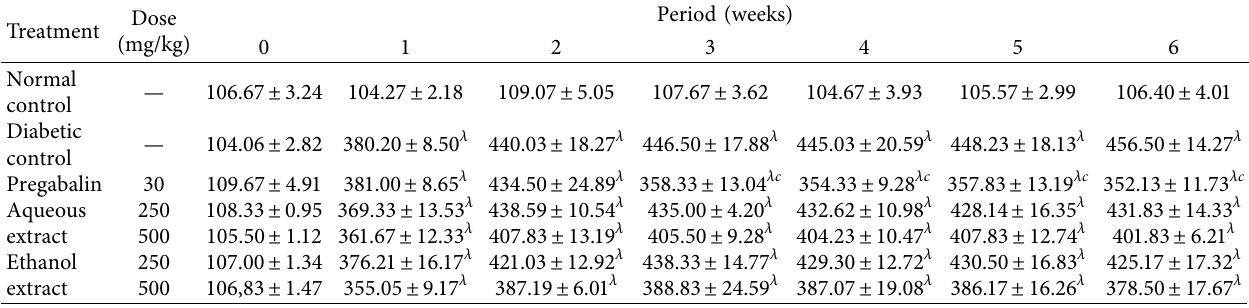
Table 1: Effects of the aqueous (AE) and ethanol (EE) extracts of Dissotis thollonii on blood glucose after injection of streptozotocin in mice. Treatment